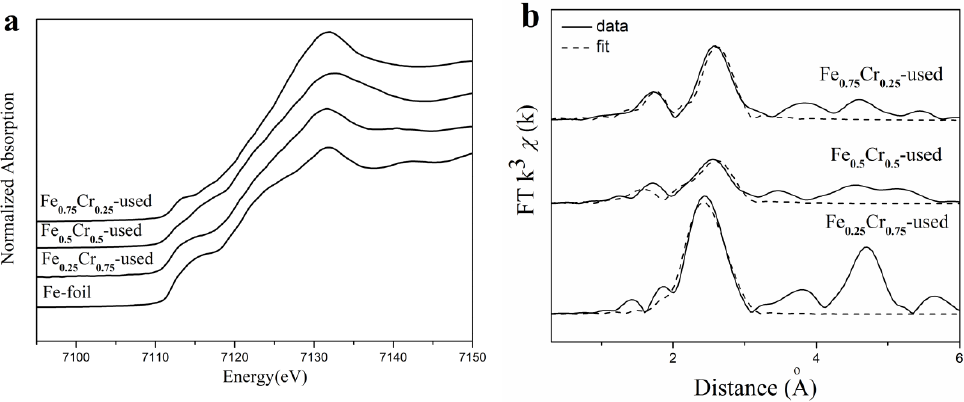
Figure 6. Fe K-edge XANES profiles ( a ), and EXAFS fitting results in R space ( b ), of used FeCrO x catalysts.